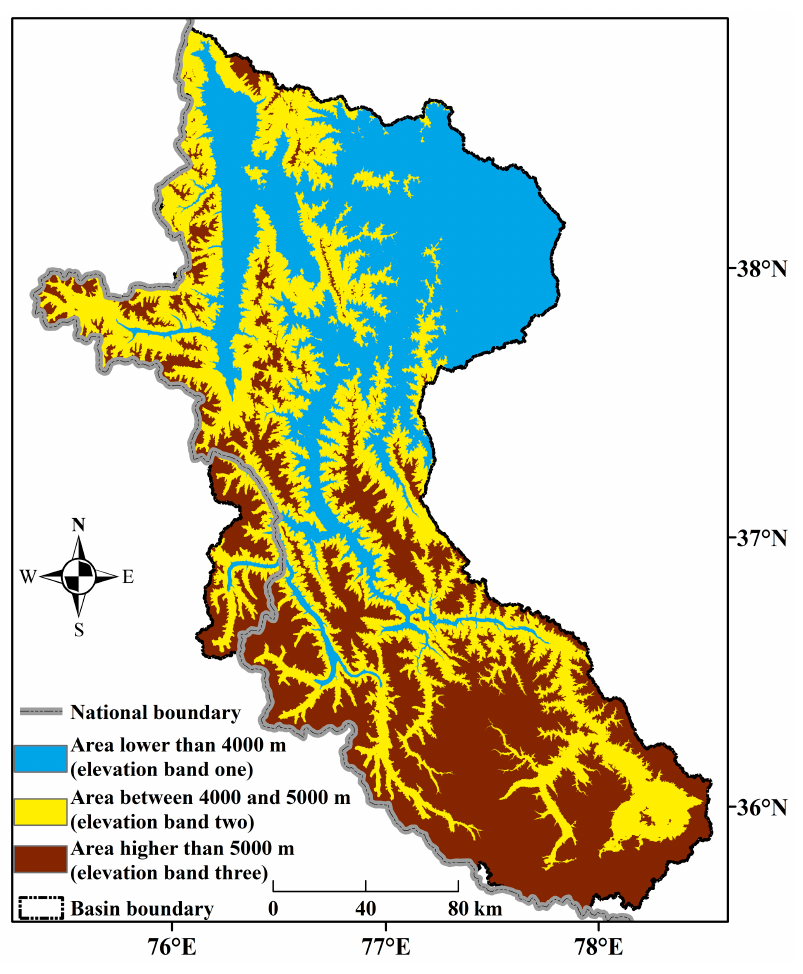
Figure 8. Elevation bands of the YRB.